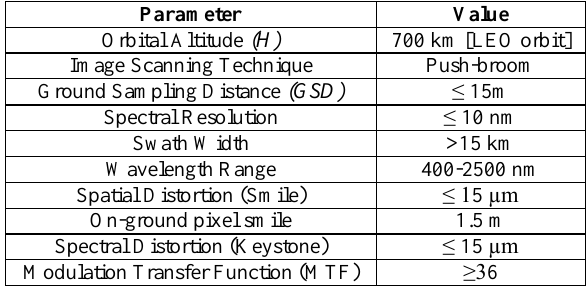
Table 2. Performance goals of the hyperspectral imager